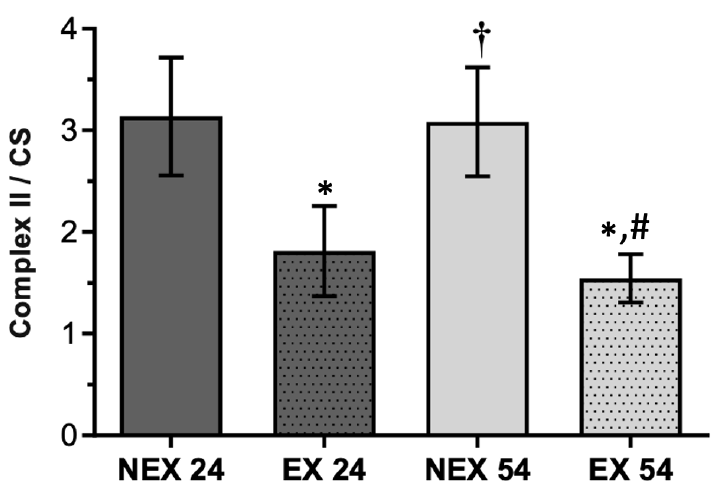
Figure 4. Effect of ageing and training in Complex II/CS. Values are means ± SD ( n = 7), with two replicates. * p < 0.05 compared with NEX24; † p < 0.05 compared with EX24; # p < 0.05 compared with NEX54; NEX24 (non-exercising young, sacrifice at 24 weeks of training), EX24 (exercise young, sacrifice at 24 weeks of training), NEX54 (non-exercising middle-age, sacrifice at 54 weeks of training), EX54 (exercise middle-age, sacrifice at 54 weeks of